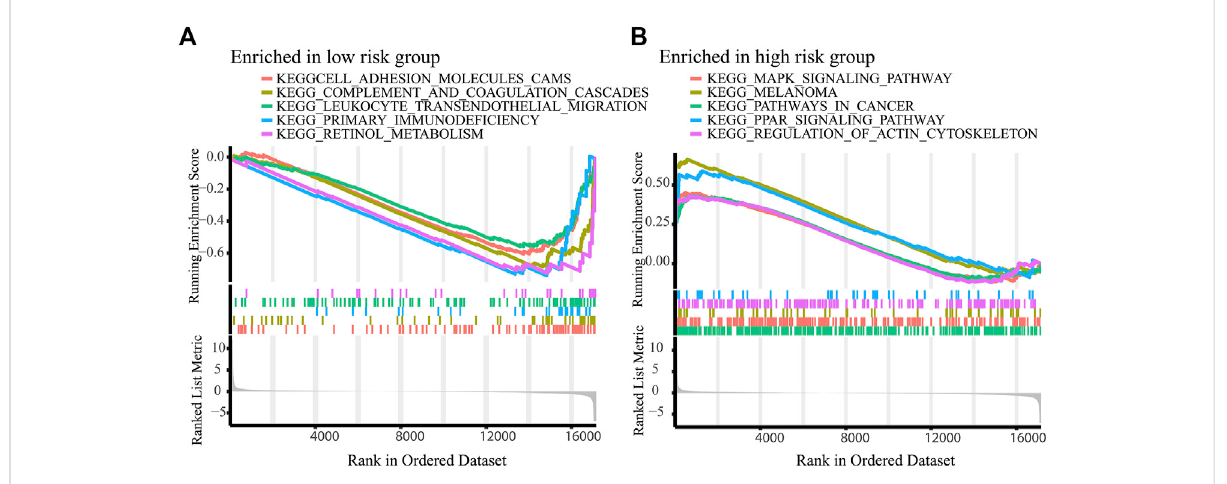
FIGURE 6 Activated pathways analyzed by GSEA. GSEA of the top 10 pathways signi fi cantly enriched in the low- (A) and high-risk group (B)